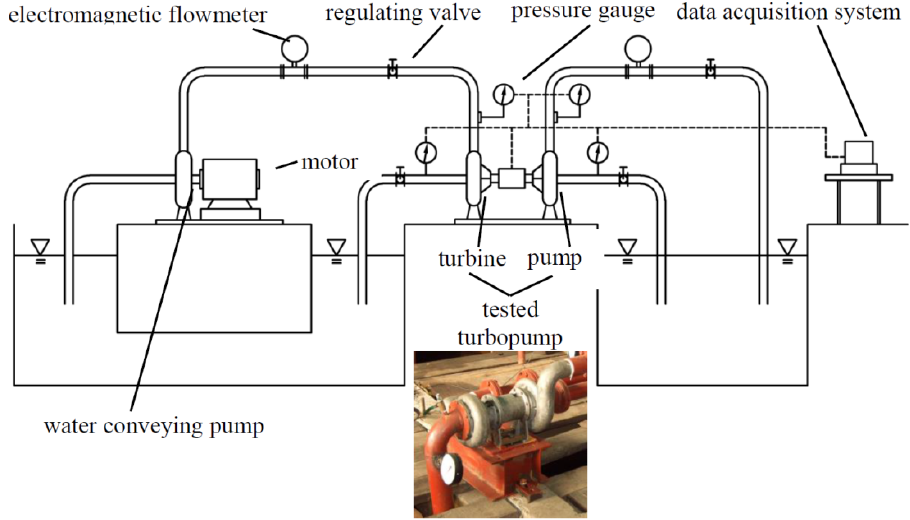
Figure 5. Schematic diagram of experimental apparatus.